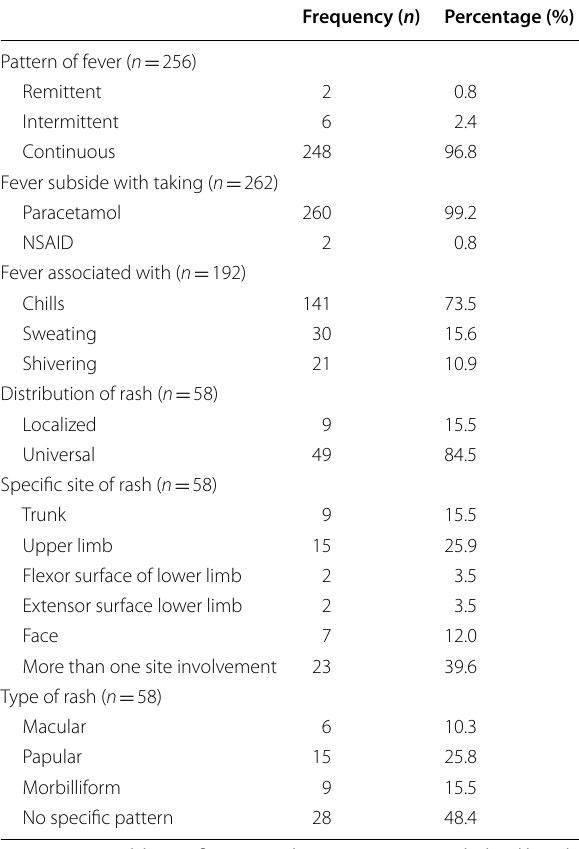
Table 3 Characteristics of fever and rash among dengue